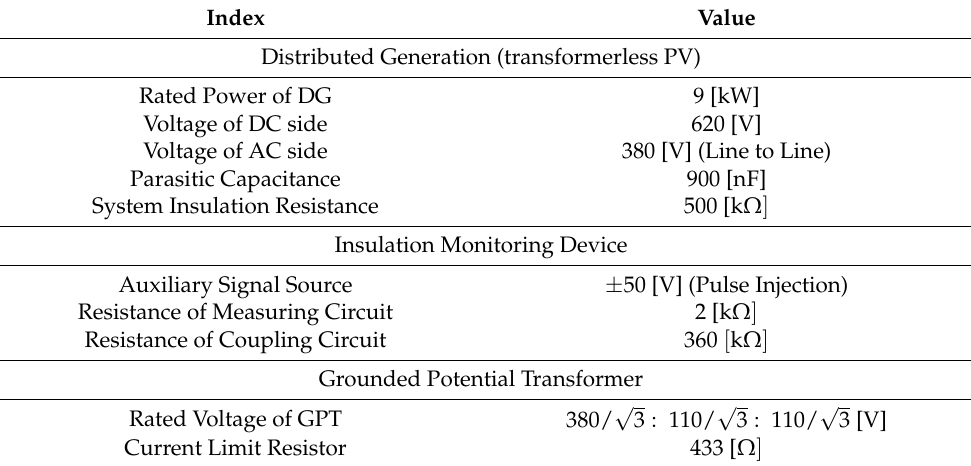
Table 1. Simulation configuration and system